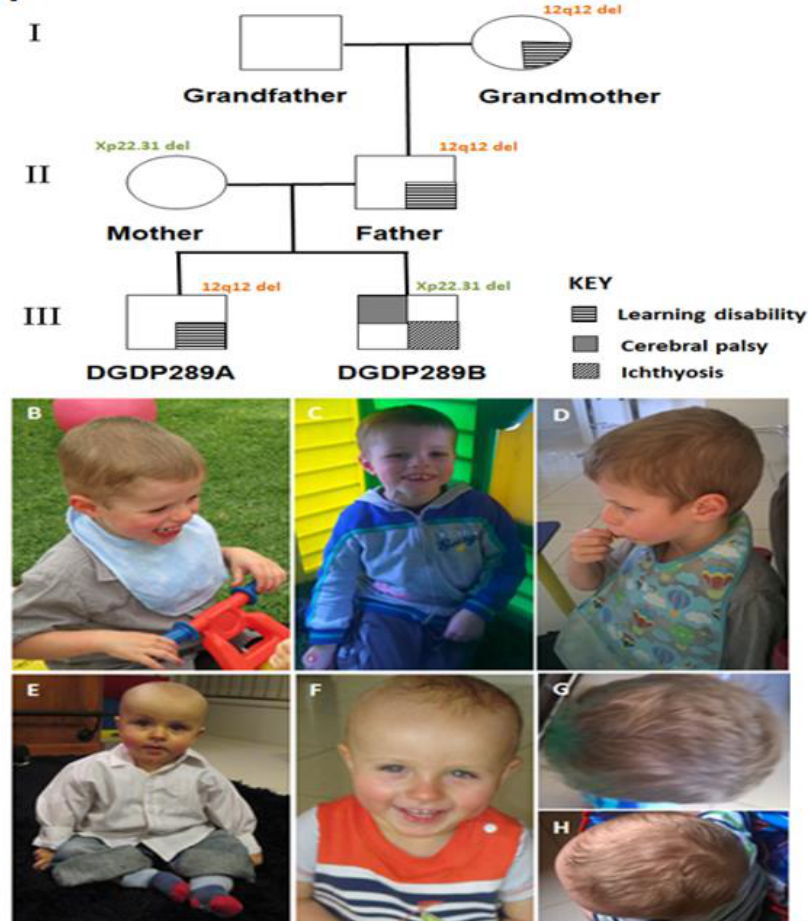
Figure 1. Pedigree and photographs of patients. ( A ) Learning disability of DGDP289A is segregated with 12q12 microdeletion in three generations. The Xp22.31 microdeletion in DGDP289B was inherited from his mother. While the mother is a healthy carrier of this deletion, her son displays ichthyosis and cerebral palsy. Patient DGDP289A has a broad and flattened forehead, as shown by pictures taken at 40 ( B ) and 41 months ( C ). ( D ) Lateral facial view of DGDP289A. DGDP289B displays notable frontal bossing, as shown by pictures taken at 11 months ( E ) and 19 months ( F ). The head shape of DGDP289A ( G ), as well as DGDP289B ( H ) from above, are also displayed.